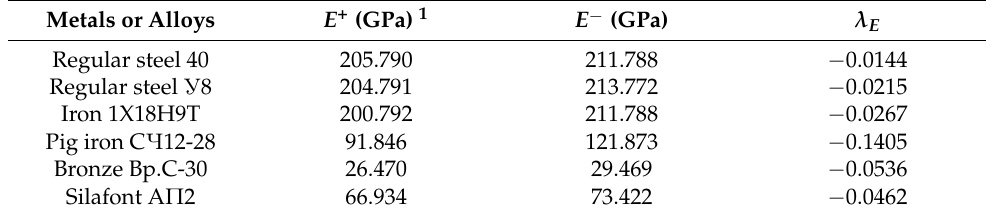
Table 1. The tensile and compressive moduli for certain metals and alloys (data from [10]) and their λ E